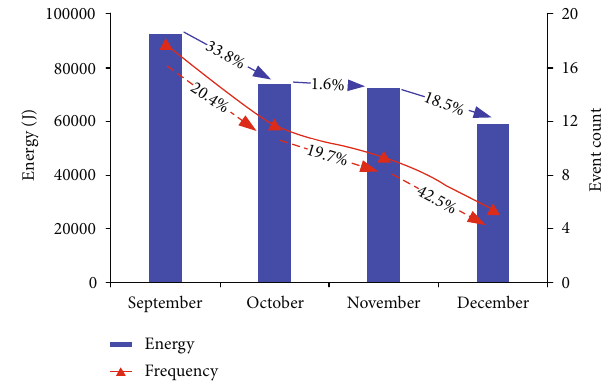
Figure 19: Analysis chart of microseismic monitoring